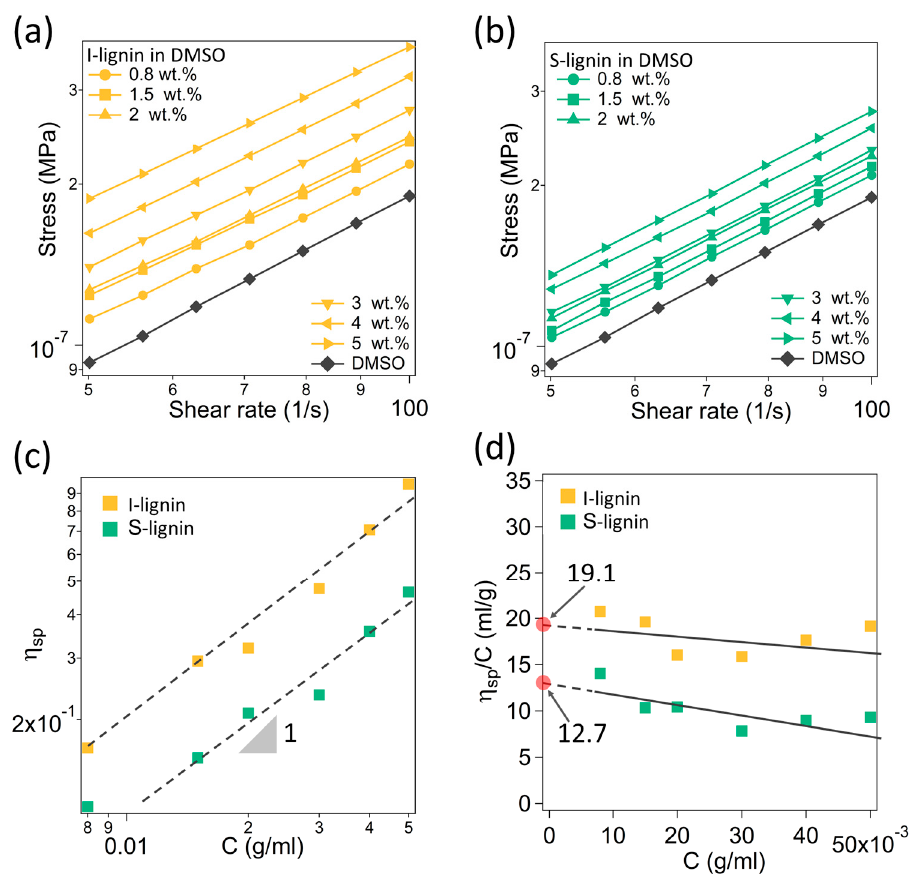
Figure 2. ( a,b ) Stress as a function of shear rate of different solutions of I-lignin and S-lignin in DMSO, respectively; ( c ) Specific viscosity of the studied samples as a function of lignin–DMSO solution concentration (a slope of 1 indicates no molecular interaction); and ( d ) Intrinsic viscosity of insoluble and soluble lignin in DMSO.